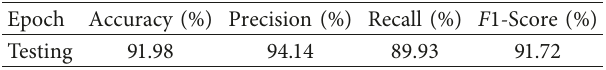
Table 11: Test results of the model using dataset II.